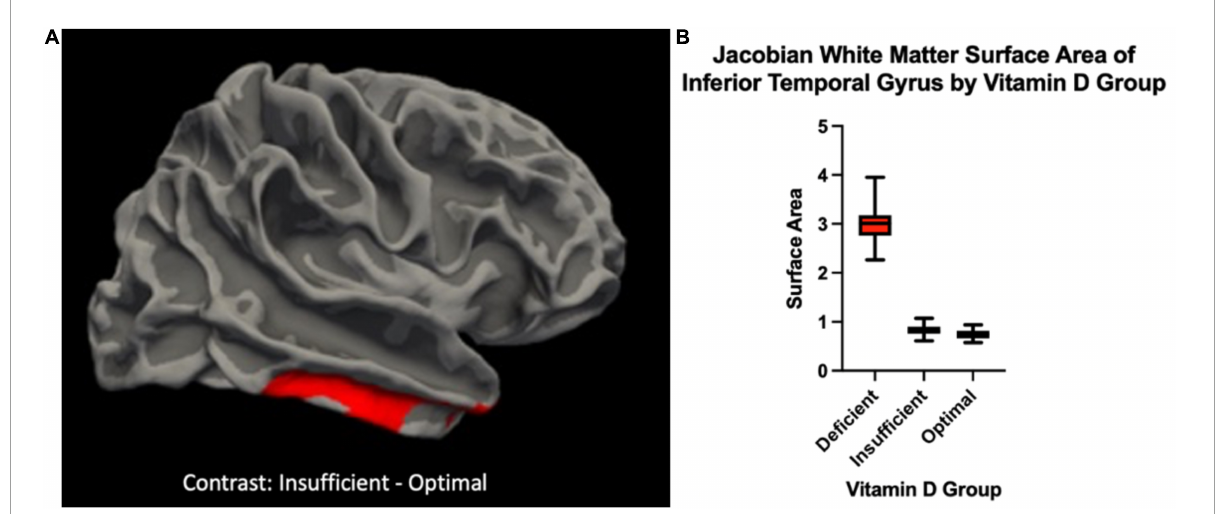
FIGURE1 (A) The Jacobian white matter surface area in a cortical cluster overlapping with the right inferior temporal gyrus {region of the Destrieux atlas [FreeSurfer aparc.a2009s (Destrieux et al., 2010)] containing the maximum T-statistics} was higher for individuals with insufficient Vitamin D levels compared to those with optimal levels. To ease visual interpretation, we have used red to represent the significant positive “Insufficient – Optimal” contrast. (B) Box-plots depicting the distribution of the Jacobian white in the cortical vertex where the T-statistics of this group comparison was maximum for each Vitamin D level group.